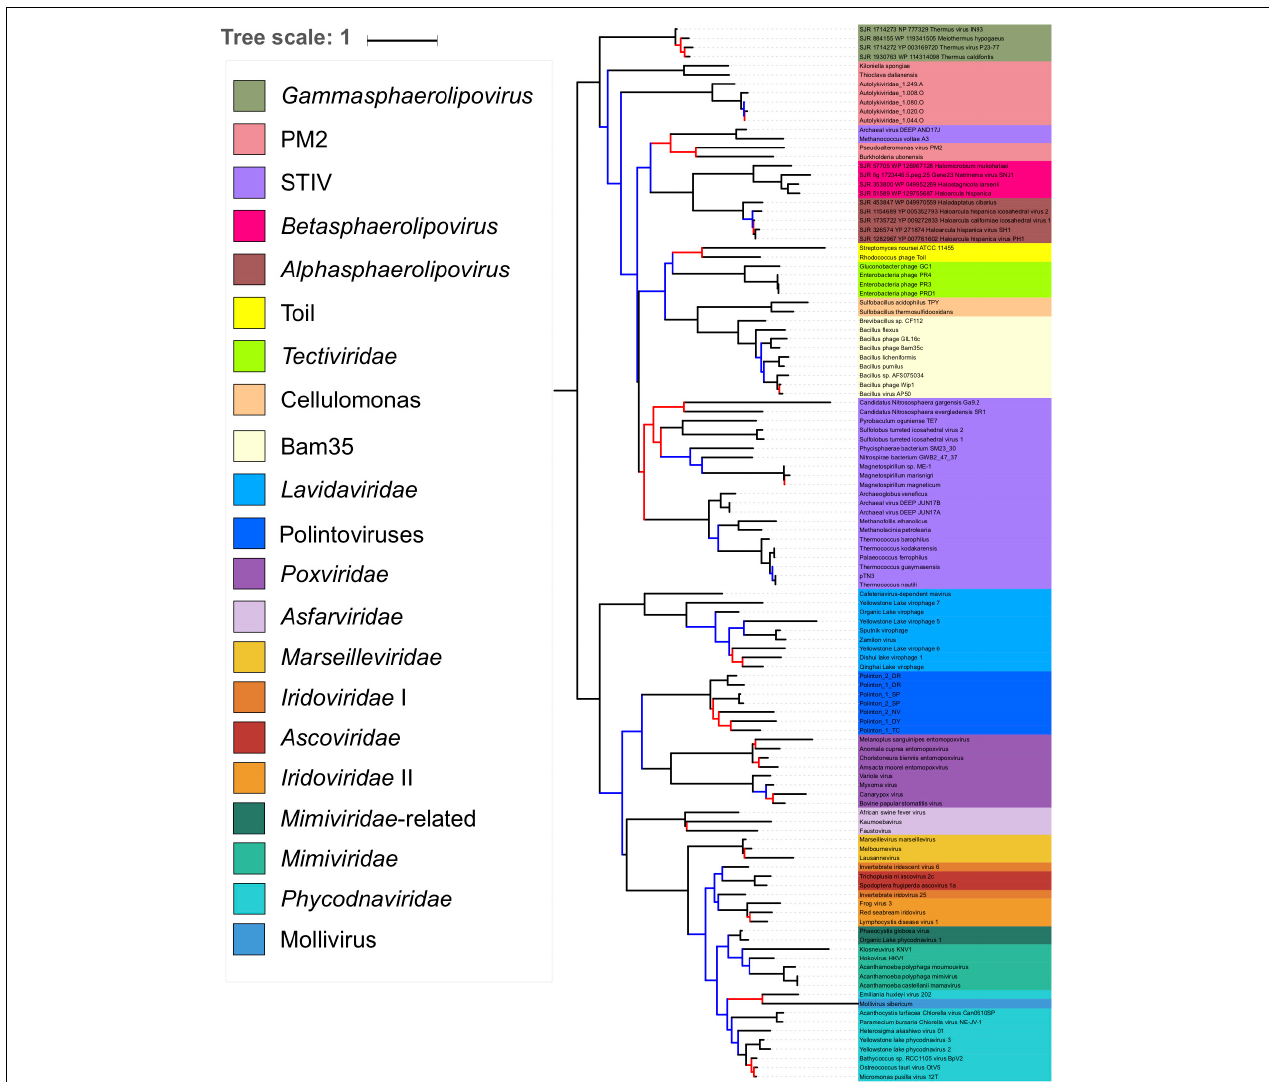
FIGURE 5 | Phylogenetic tree of the packaging ATPase gene of the Varidnaviria realm, excluding Adenoviridae. The alignment has 116 sequences with 151 positions. The root of the phylogenetic tree was between the prokaryotic and eukaryotic members. The scale-bar indicates the average number of substitutions per site. The best-fit model was LG + R6, which was chosen according to Bayesian Information Criterion (BIC). Branches in black indicate both classical bootstrap and transfer bootstrap expectation (TBE) support values using 1,000 replicates are above 70%. Branches in blue indicate only one of the two support values is above 70% whereas branches in red indicate both support values are below